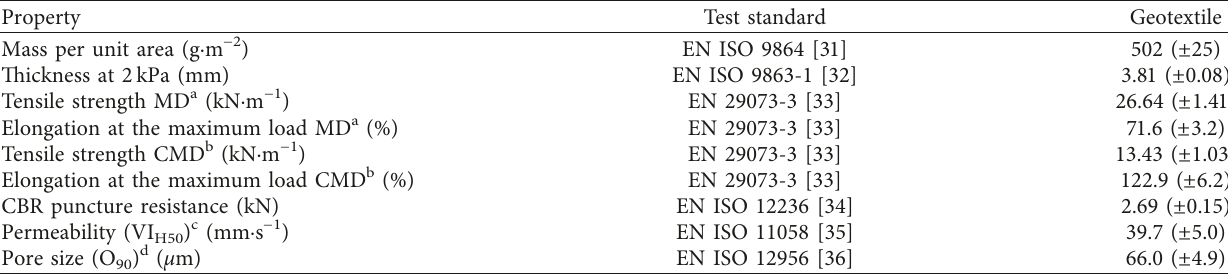
Table 1: Main properties of the geotextile (undamaged sample).